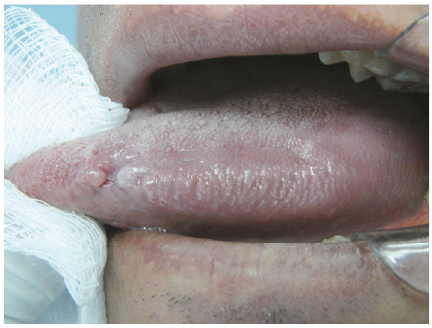
Figure 1: Clinical aspect of the oral hairy